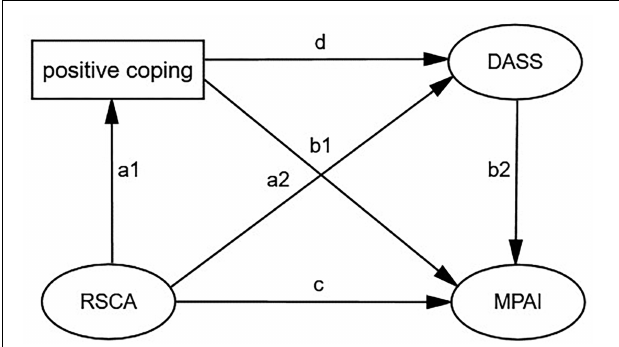
FIGURE 1 | Hypothesized model. MPAI, Mobile Phone Addiction Index; DASS-21, Depression, Anxiety, and Stress Scale with 21 Items; RSCA, the Resilience Scale for Chinese Adolescents; SCSQ, the Simplified Coping Style